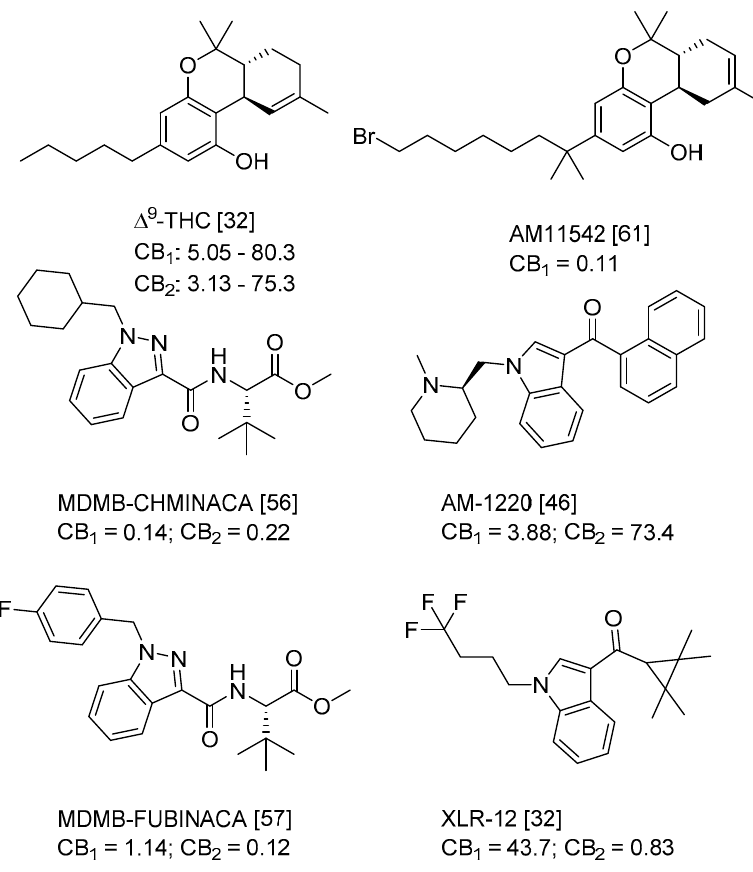
Figure 1. Structure of ∆ 9 -THC, AM11542, MDMB-CHMINACA, AM-1220, MDMB-FUBINACA, and XLR-12 along with their K i (nM).